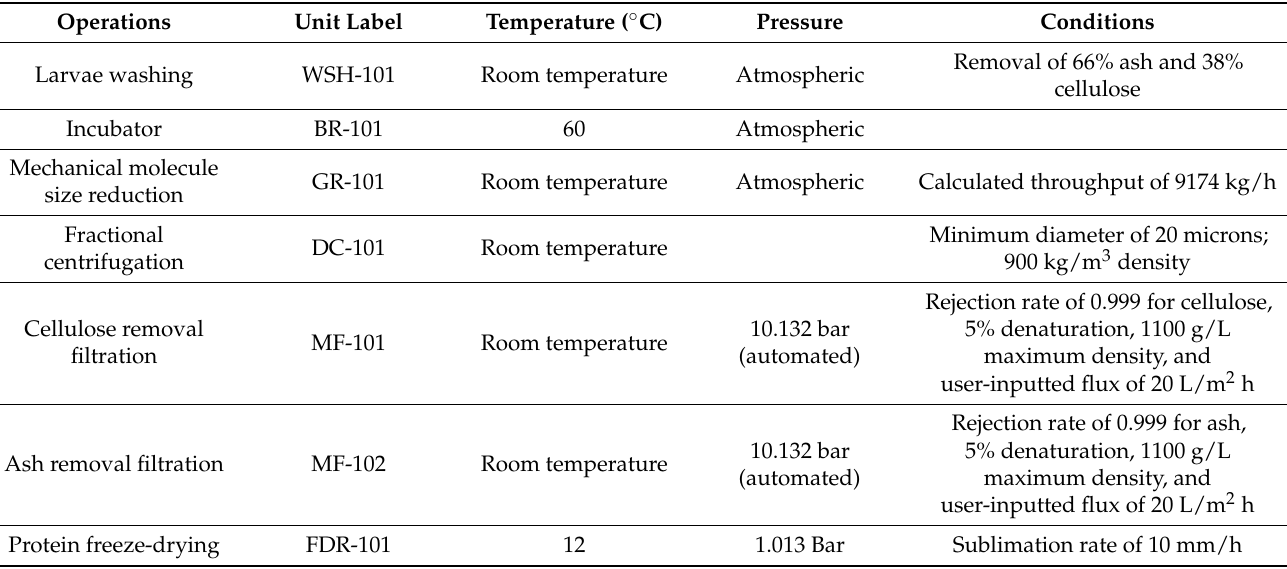
Table 4. Process conditions within the